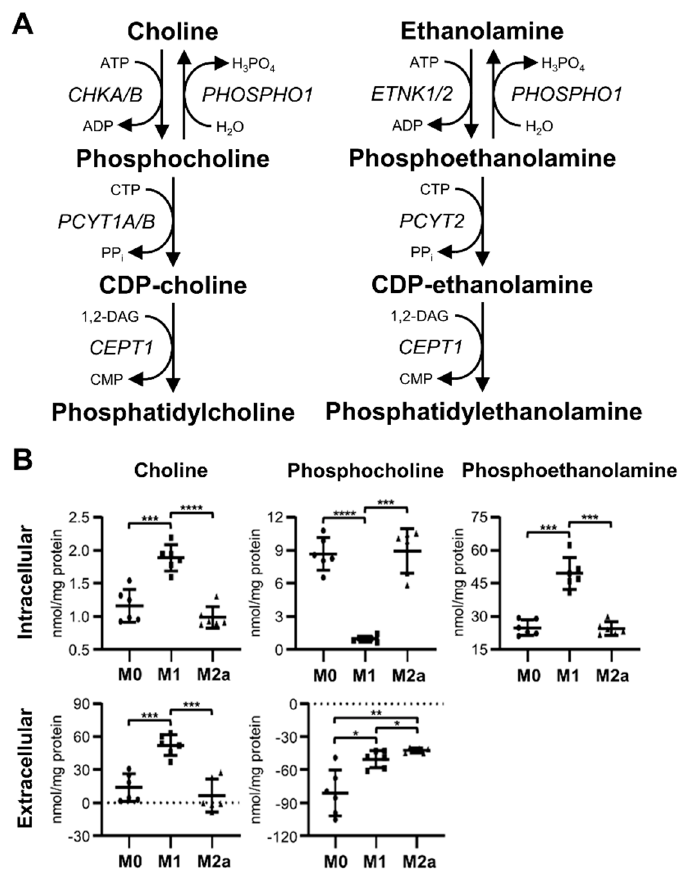
Figure 5. M1 M Φ s have a distinct metabolic signature characterized by alterations of metabolite flow within the Kennedy pathway. Schematic diagram of metabolite flow through the Kennedy pathway ( A ), and quantitative levels of corresponding metabolites ( B ) detected in intra- and extracellular M Φ metabolite extracts (mean ± SD). Unpaired parametric t-tests with Welch’s correction (two-tailed; * p < 0.05; ** p < 0.01; *** p < 0.001; **** p <